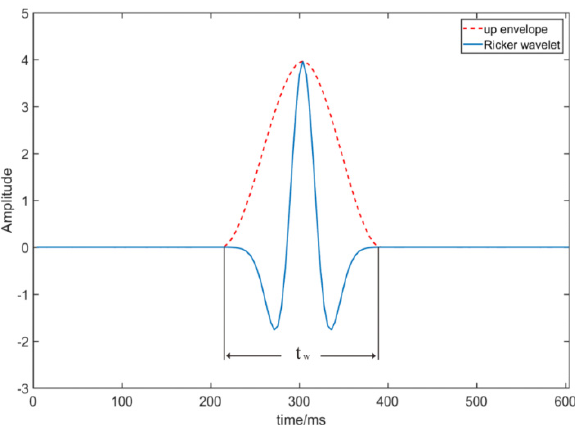
Figure 2. The waveform of Ricker wavelet and its upper envelope.